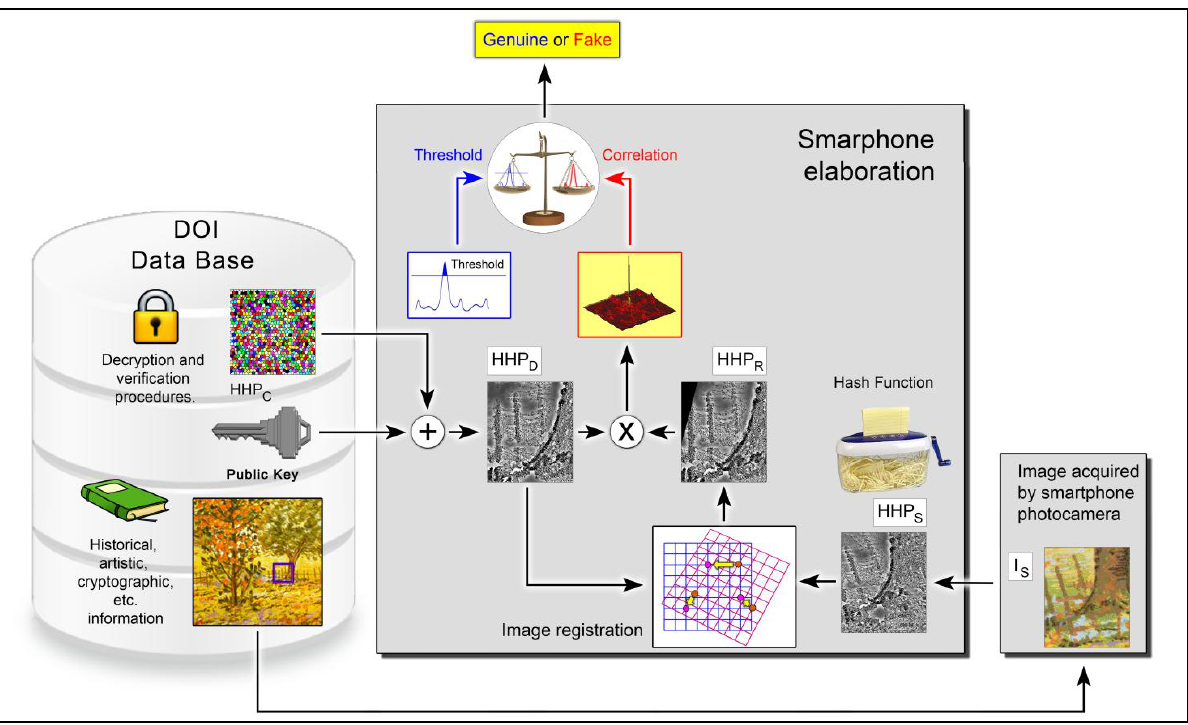
Figure 7. Complete schema showing the verification procedure